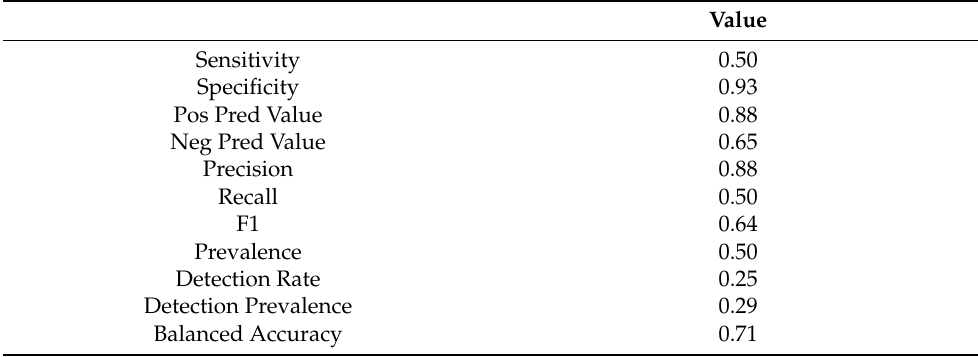
Table 4. Decision tree. Metrics of the model.